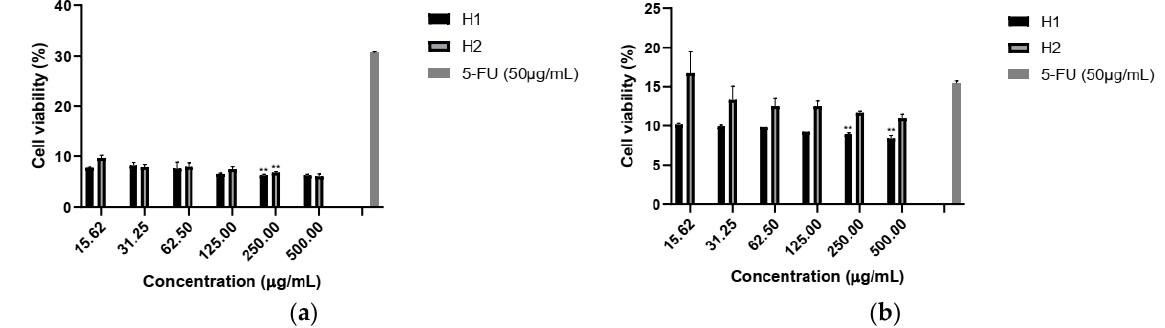
Figure 5. Viability of Jurkat cells after ( a ) 24 h and ( b ) 48 h exposure to hellebore extracts. Positive control, 5-fluorouracil (5-FU) (50 µg/mL). Values represent mean ± SD (n = 3, ** p < 0.01).